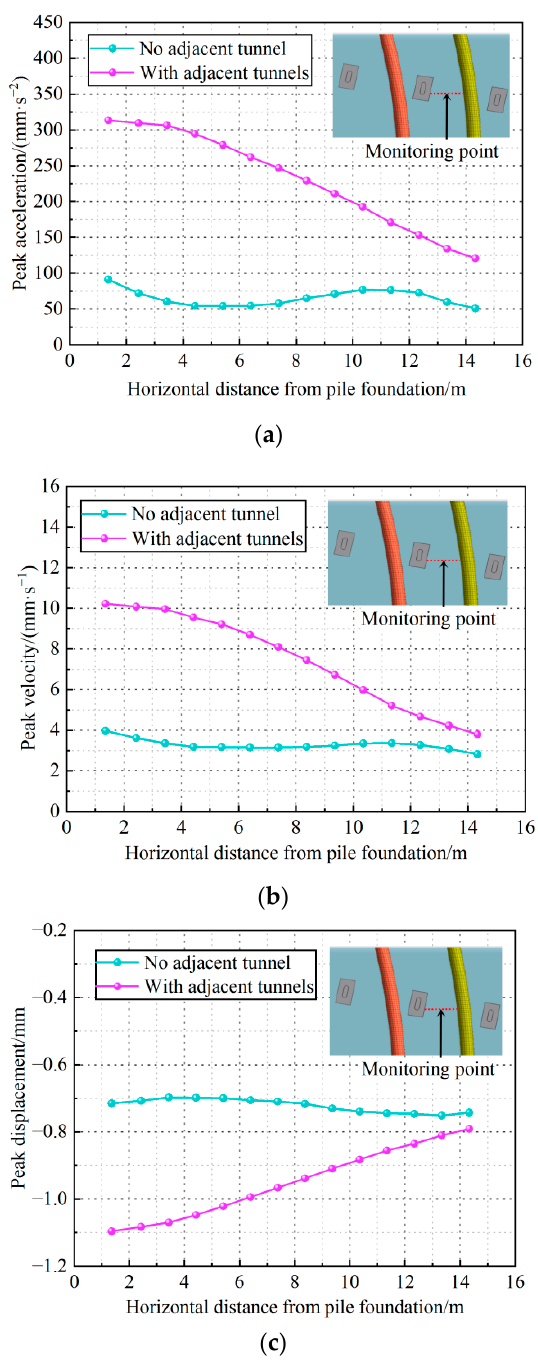
Figure 10. Horizontal dynamic response characteristics of the foundation. ( a ) Peak vibration acceleration. ( b ) Peak vibration velocity. ( c ) Peak vibration displacement.